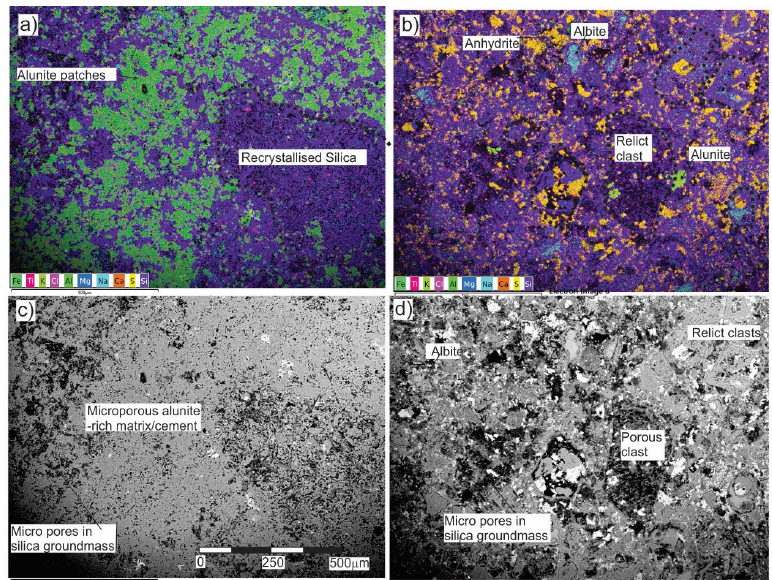
Figure 4. Scanning Electron Microscopy EDS (Energy Dispersive X-ray Spectroscopy) element maps and backscatter images, respectively, of ( a ) and ( c ) ash tuff matrix of a hydrothermal breccia from block 2-3; ( b ) and ( d ) ash tuff block 3-3.